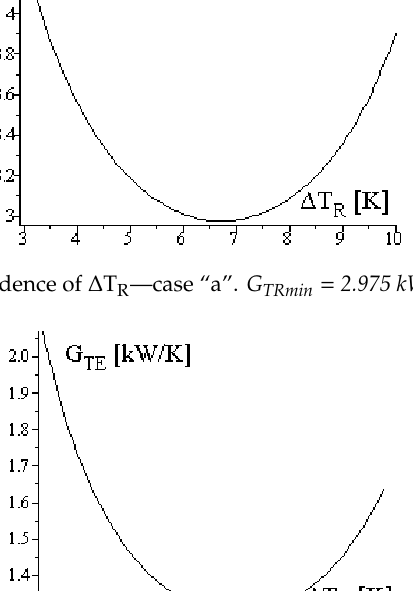
Figure 16. G TE dependence of Δ T H —case “b”. G TEmin = 1.296 for ∆ TH = 257 K.